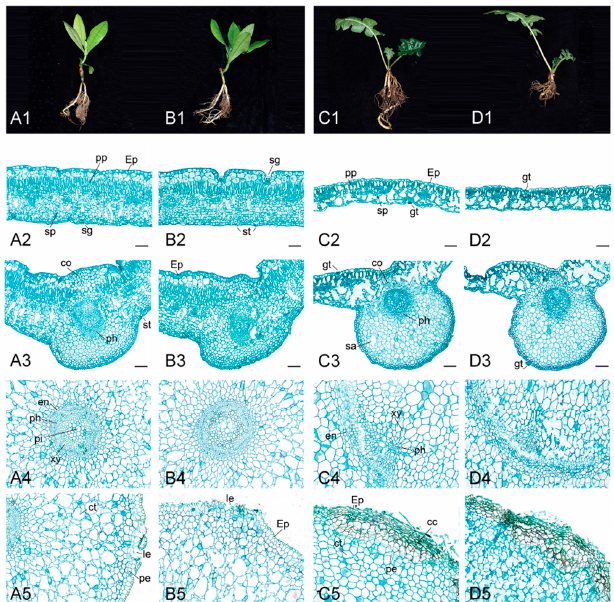
Figure 2. Phenotypic and anatomical changes of A. ilicifolius and A. mollis exposed to tidal flooding for 10 days. ( A1 – A5 ) A. ilicifolius plants on control treatment, ( B1 – B5 ) A. ilicifolius plants under tidal flooding stress, ( C1 – C5 ) A. mollis plants on control treatment, ( D1 – D5 ) A. mollis plants under tidal flooding stress. Row 1: The phenotypic of Acanthus species, Row 2: The cross-section of the leaf blade, Row 3: The main vein of the leaf, Row 4: Stele of root, Row 5: Epidermis of root. Root sections, about 5 cm from root tip, photos of optical microscopes. Cross-sections with thickness of 10 mm were made and stained with safranine and fast green. cc: Cork cambium; co: Collenchyma; ct: Cortex; en: Endodermis; Ep: Epidermis; gt: Glandular trichome; le: Lenticel; pe: Periderm; ph: Phloem; pi: Pith; pp: Palisade parenchyma; sa: Schizogenous aerenchyma; st: Stomata; sp: Lacunar parenchyma; xy: Xylem. Bars = 100 μ m.